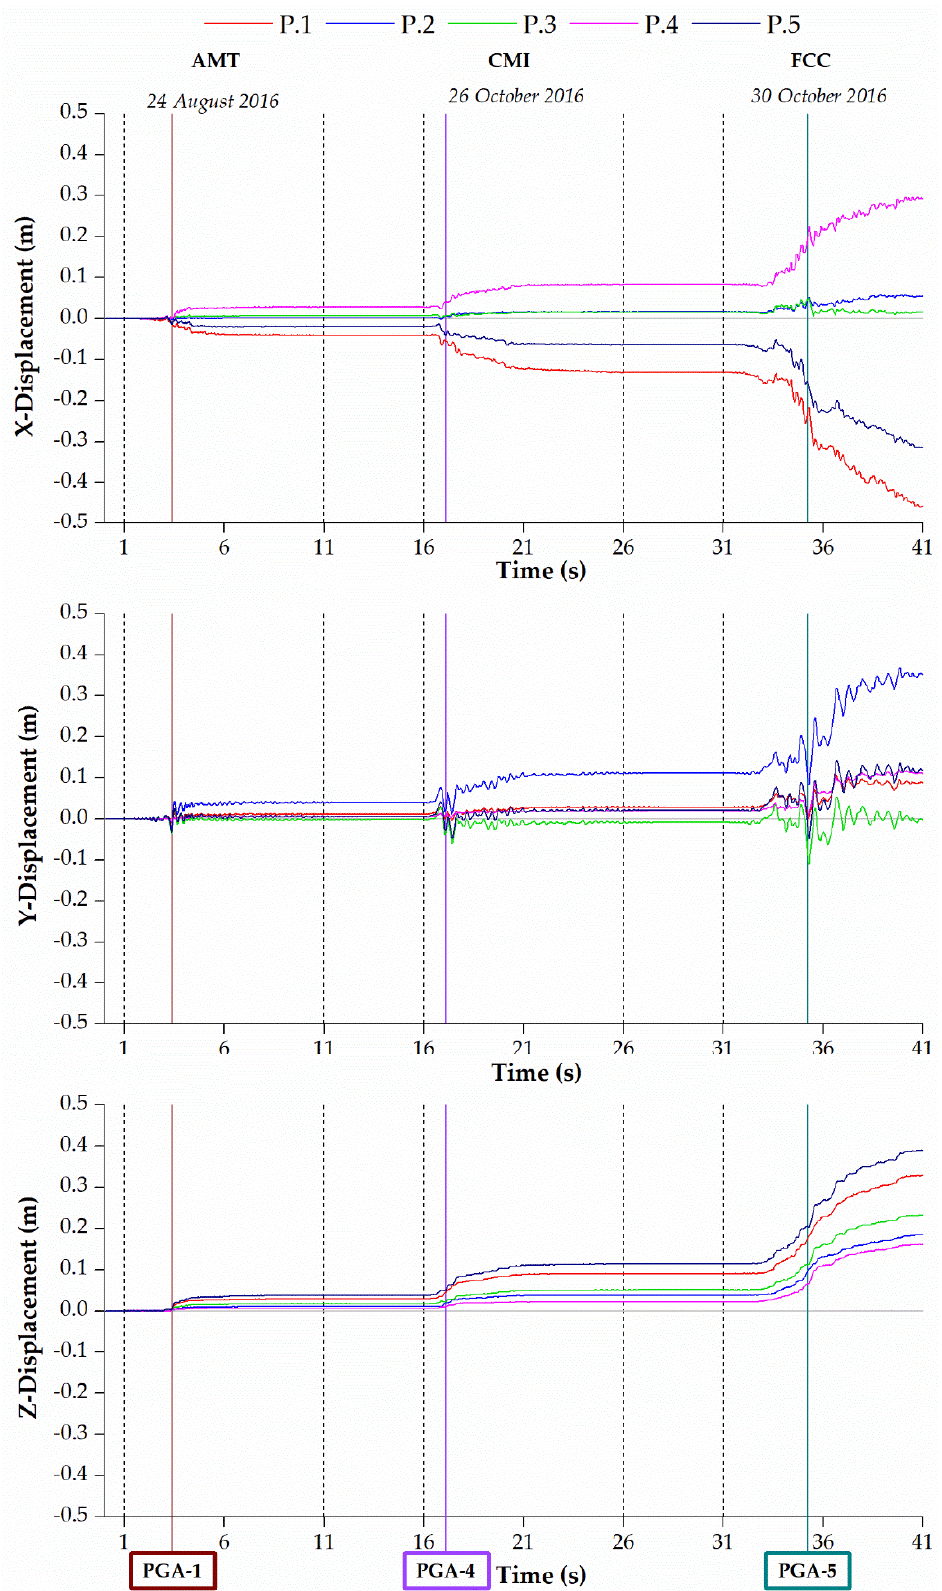
Figure 14. Displacements THs in the x, y, and z directions of the five church monitoring points calculated with nonlinear dynamic analyses by means of the CDP model under the epicentral seismic actions.